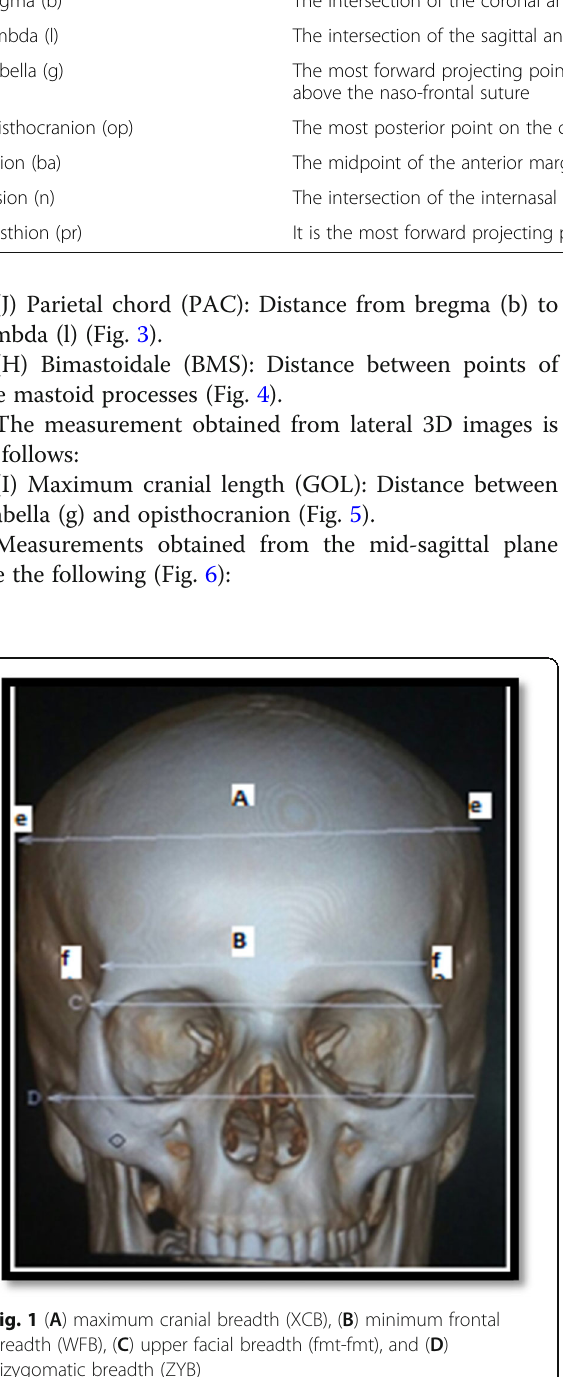
Fig. 2 ( E ) orbital height (OBH),( F ) orbital breadth